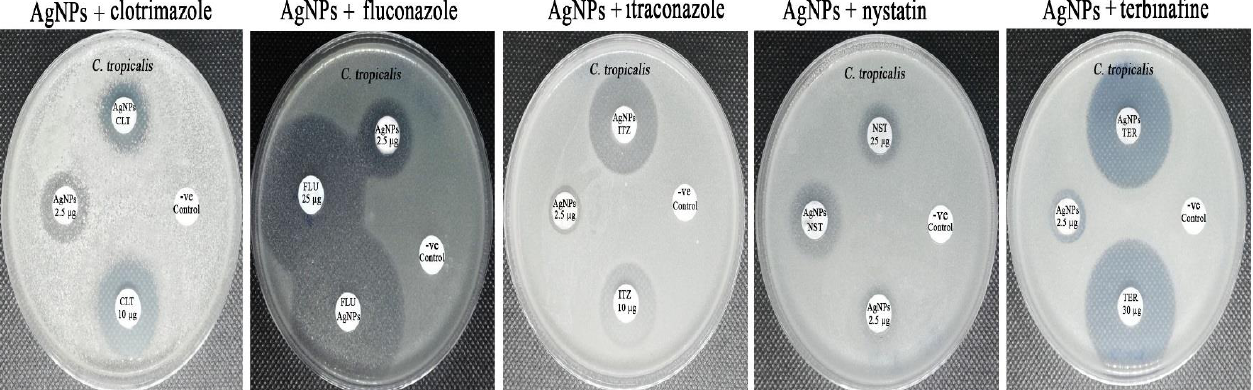
Figure 12. Synergistic patterns of biogenic AgNPs with different antifungal agents against C. glabrata strain.